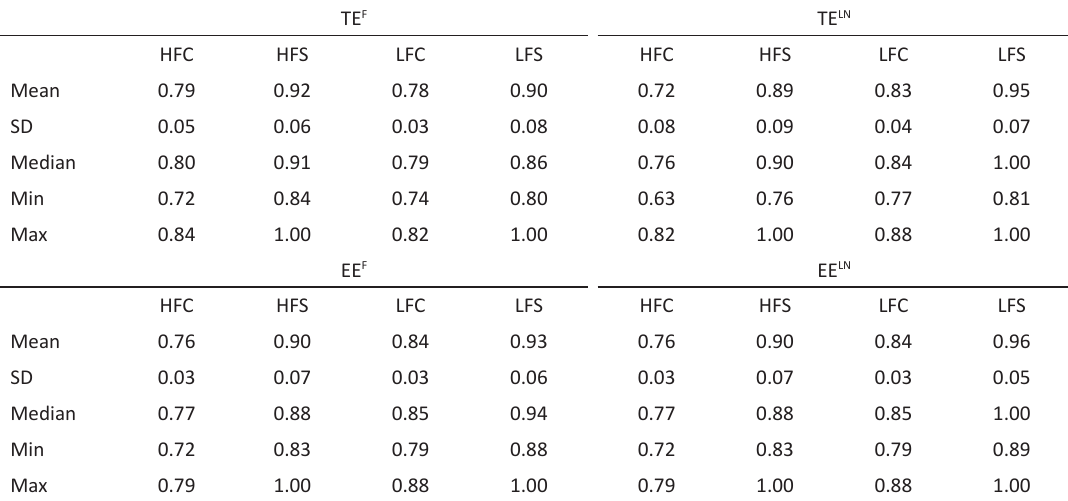
Table 2. DEA efficiency scores for TE and EE per system averaged across the years 2004–2010 TE F TE LN